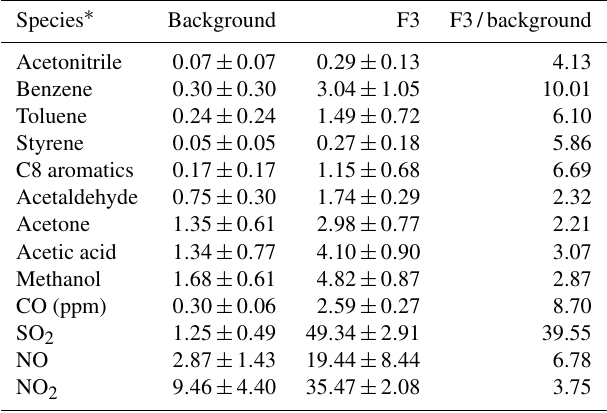
Table 4. Average concentrations of VOCs, CO, SO 2 , and NO x at a background period and a firework